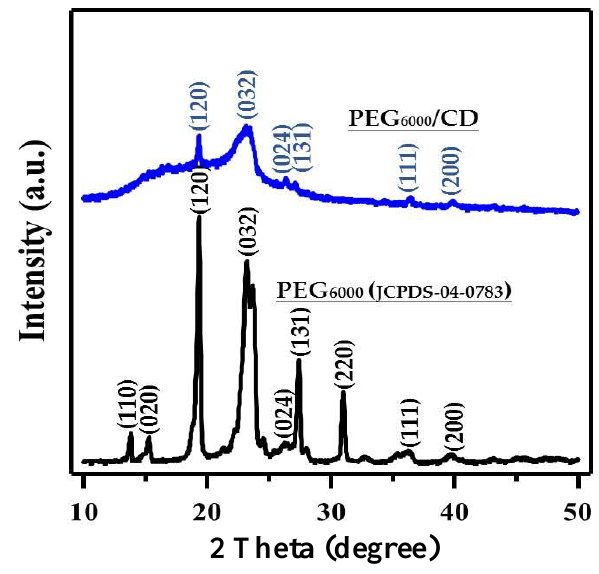
Figure 2. X-ray di ff raction (XRD) pattern of PEG 6000 / CD composite. Here the standard XRD pattern of Figure 2. X-ray diffraction (XRD) pattern of PEG 6000 /CD composite. Here the standard XRD pattern polyethylene glycol 6000 (PEG 6000 ) is given for comparison of polyethylene glycol 6000 (PEG 6000 ) is given for comparison (JCPDS-04-0783).